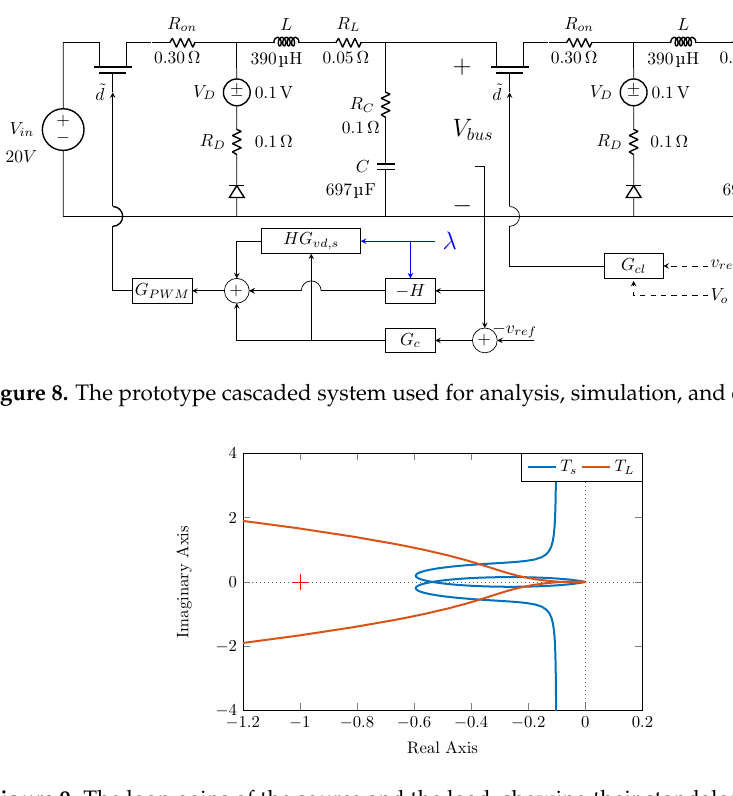
Figure 9. The loop gains of the source and the load, showing their standalone